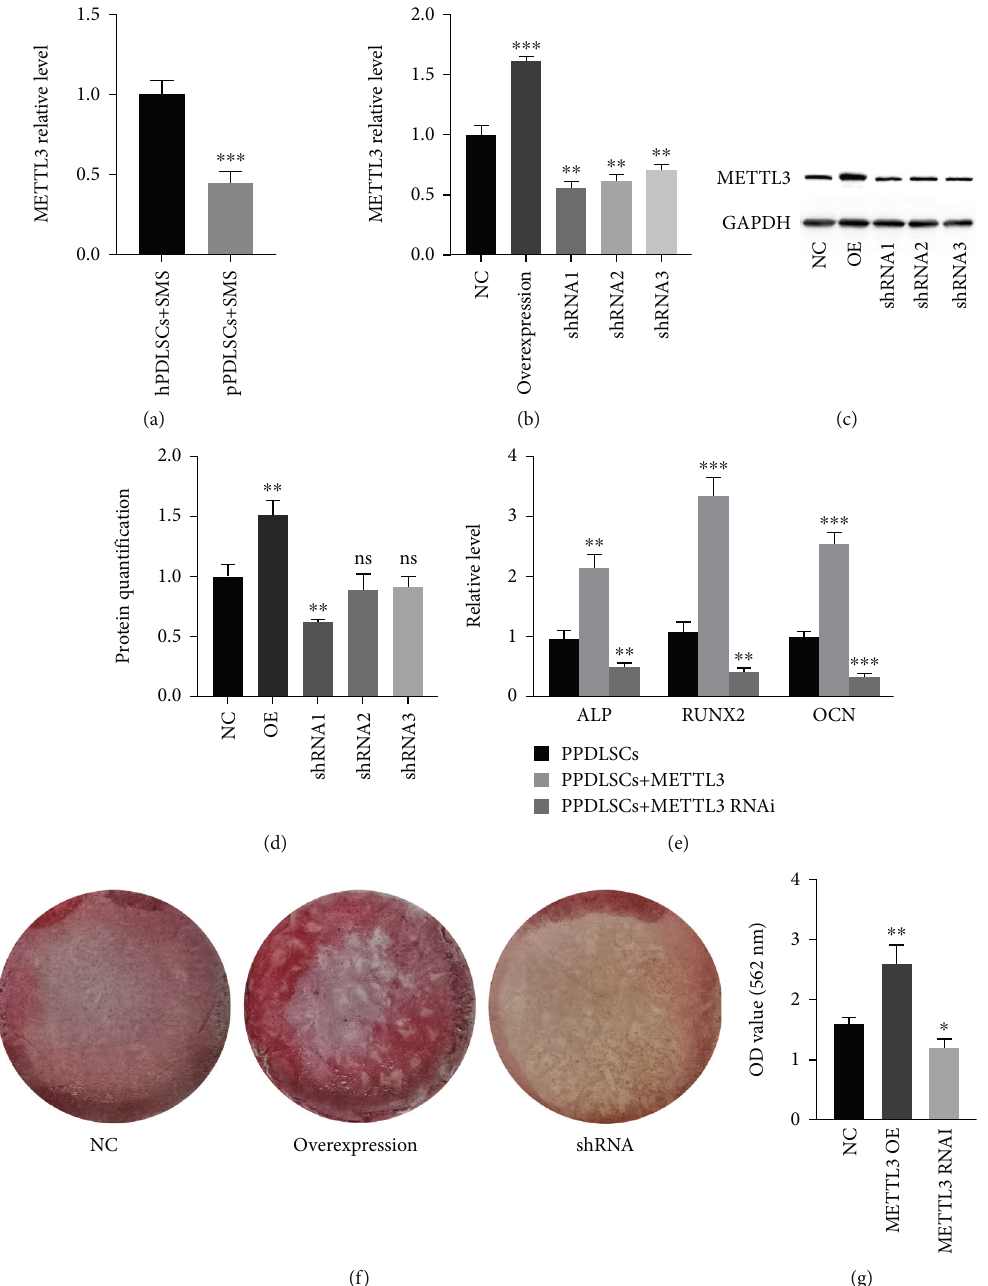
Figure 6: METTL3 is di ff erentially expressed in stained pPDLSCs and promotes the osteogenic di ff erentiation of pPDLSCs. The relative expression level of METTL3 in hPDLSCs and pPDLSCs under strain (a). The e ff ects of lentiviruses on METTL3 were determined by qPCR (b), western blotting (c) and quanti fi cation analysis (d). The expression levels of osteogenesis-related genes (ALP, RUNX2, and OCN) after 7 days of osteogenic induction (e). Alizarin Red staining and quanti fi cation analysis after 21 days of osteogenic induction (f and g). OE, overexpression. ∗ p < 0 : 05 , ∗∗ p < 0 : 01 , ∗∗∗ p < 0 : 001 ns p > 0 : 05